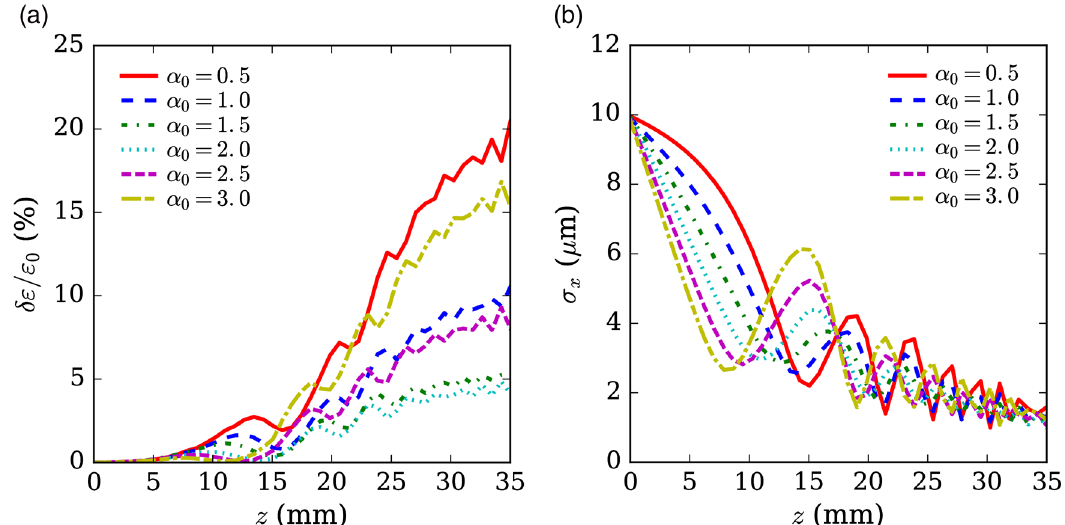
FIG. 3. Beam emittance (a) and size (b) evolutions in the up